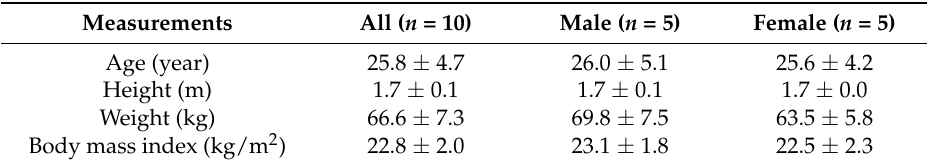
Table 1. Subject